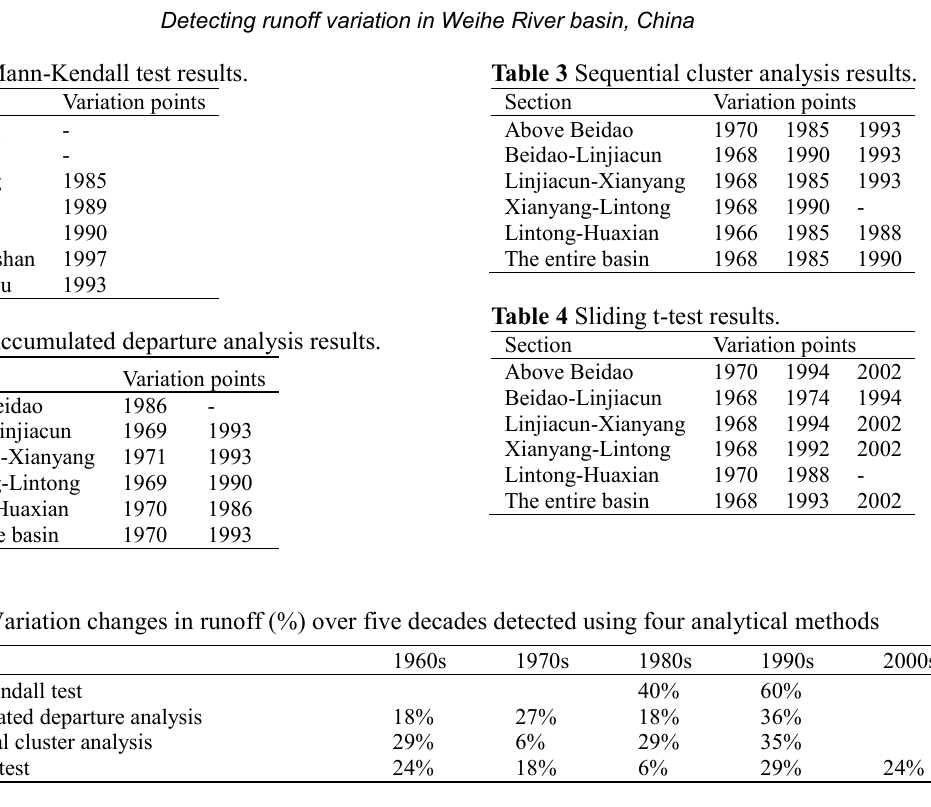
Table 6 Contributions to runoff and slope change ratio of cumulative quantity (SCRCQ) results for the time periods before, during and after shifts in the hydrological regime.